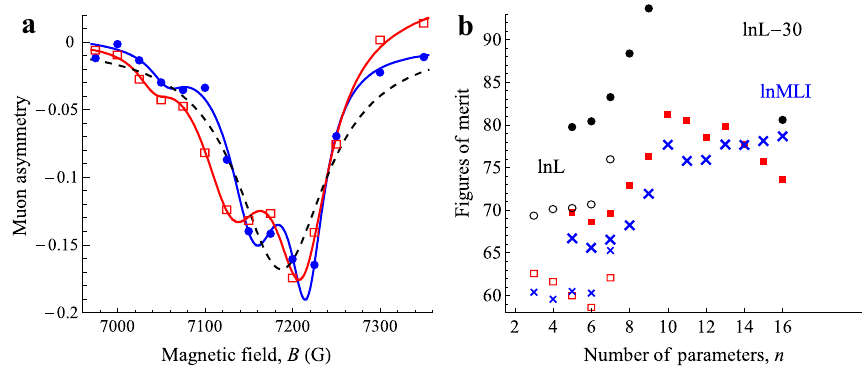
Figure 1. Muon-spin spectroscopy. Data from an experiment, muon polarisation as a function of magnetic field 27 , is shown in ( a ). Error bars on the data are estimated at ± 0.015. Linear background functions due to positrons have already been subtracted from the data. The blue solid-circle datapoints ( • ) were recorded in the dark, while the red open-square datapoints ( □ ) were photo-excited. The blue and red solid lines show 19-parameter fits of three Lorentzian peaks and two linear backgrounds, separately for the data in the dark (bluesolid line) and photo-excited (red chain-dotted line). In ( b ), the evolution of the figures of merit of the fit with the number n of fitting parameters is shown ( ■ SBIC, × lnMLI, • ln L with the last four points shifted down by 30). The open or small data points from three to seven parameters are for a single peak. The solid or large datapoints from five to 16 parameters are for two peaks, and from 17 to 20 parameters for three peaks. (Figure prepared using Mathematica 12.0, www. wolfr am. com/ mathe